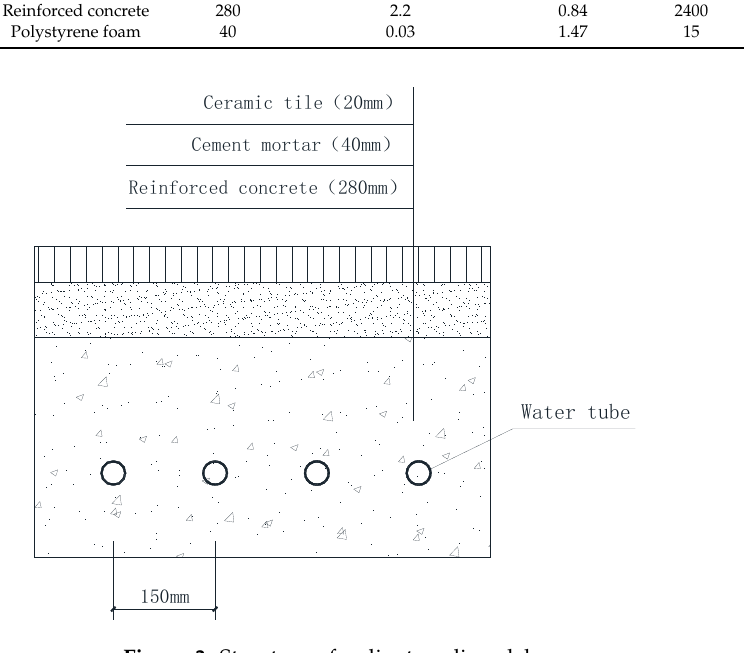
Figure 3. Structure of radiant cooling slab. Table 2. Relevant geometric and thermophysical parameters of tubes embedded (PE-X) in